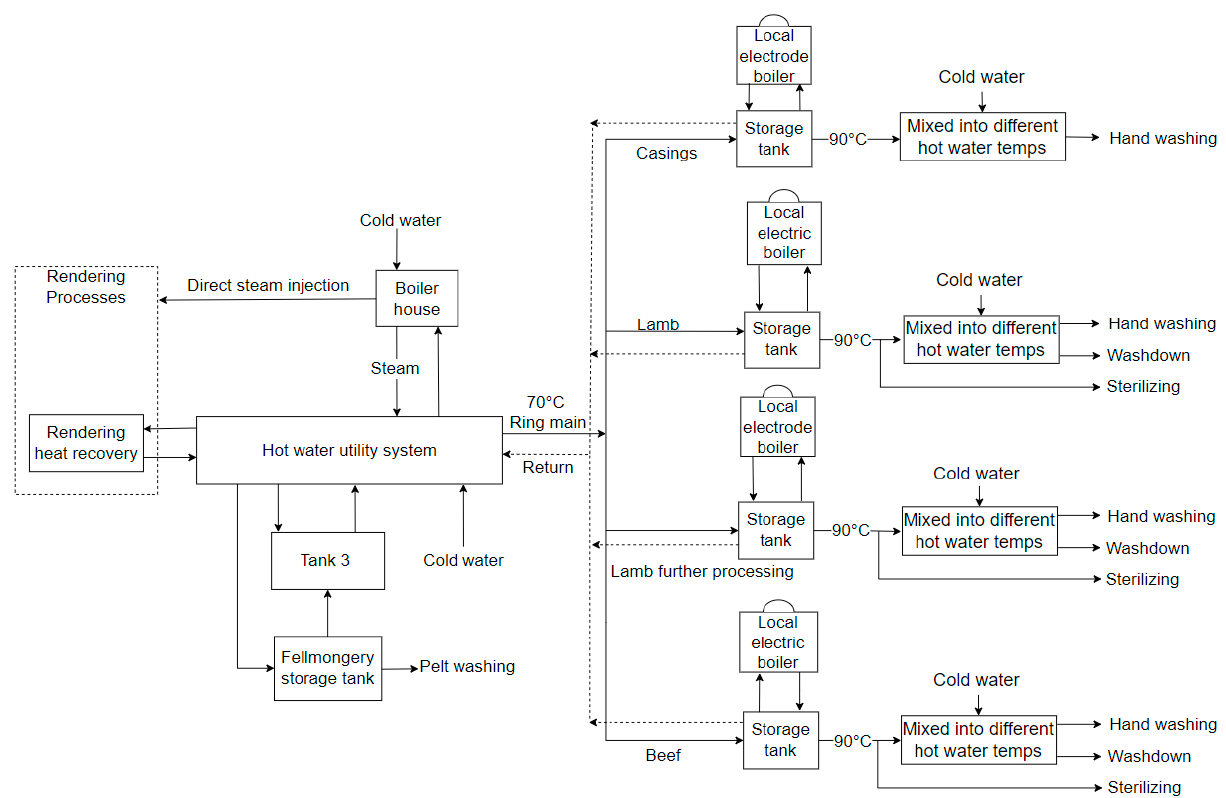
Figure 1. Simplified flow diagram of the utility system at the case study site before any heat pump installation plans are